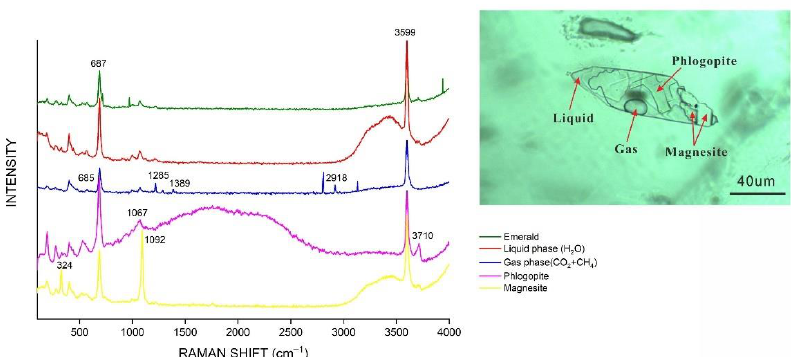
Figure 10. This multi-phase inclusion in Indian emerald clearly displays a gas bubble and some solid crystal inclusions. Raman spectroscopy was used to identify the host emerald (green), the liquid phase: water (red), the CO 2 + CH 4 gas bubble (blue), the phlogopite crystal (purple), and the magnesite crystal (yellow). The spectra are stacked for clarity.